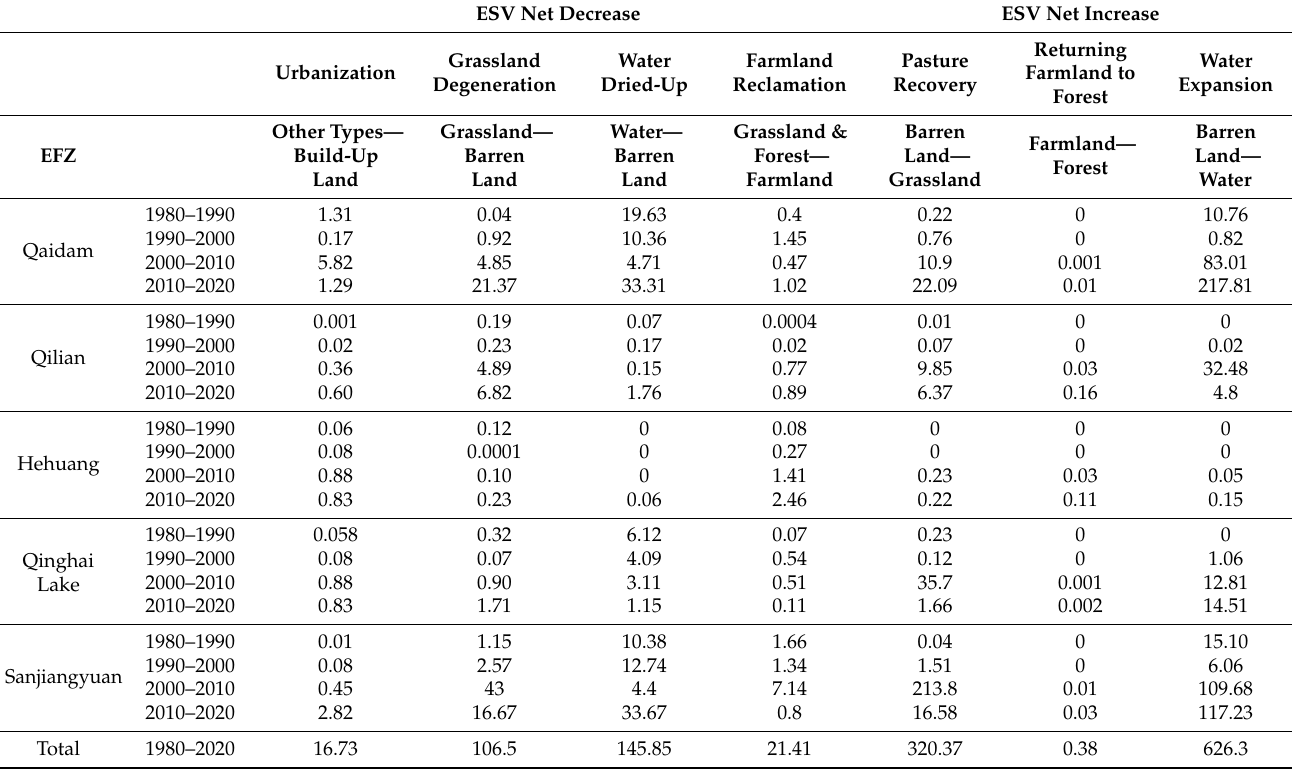
Table 5. Impacts of LUCC conversion on ESV change in different